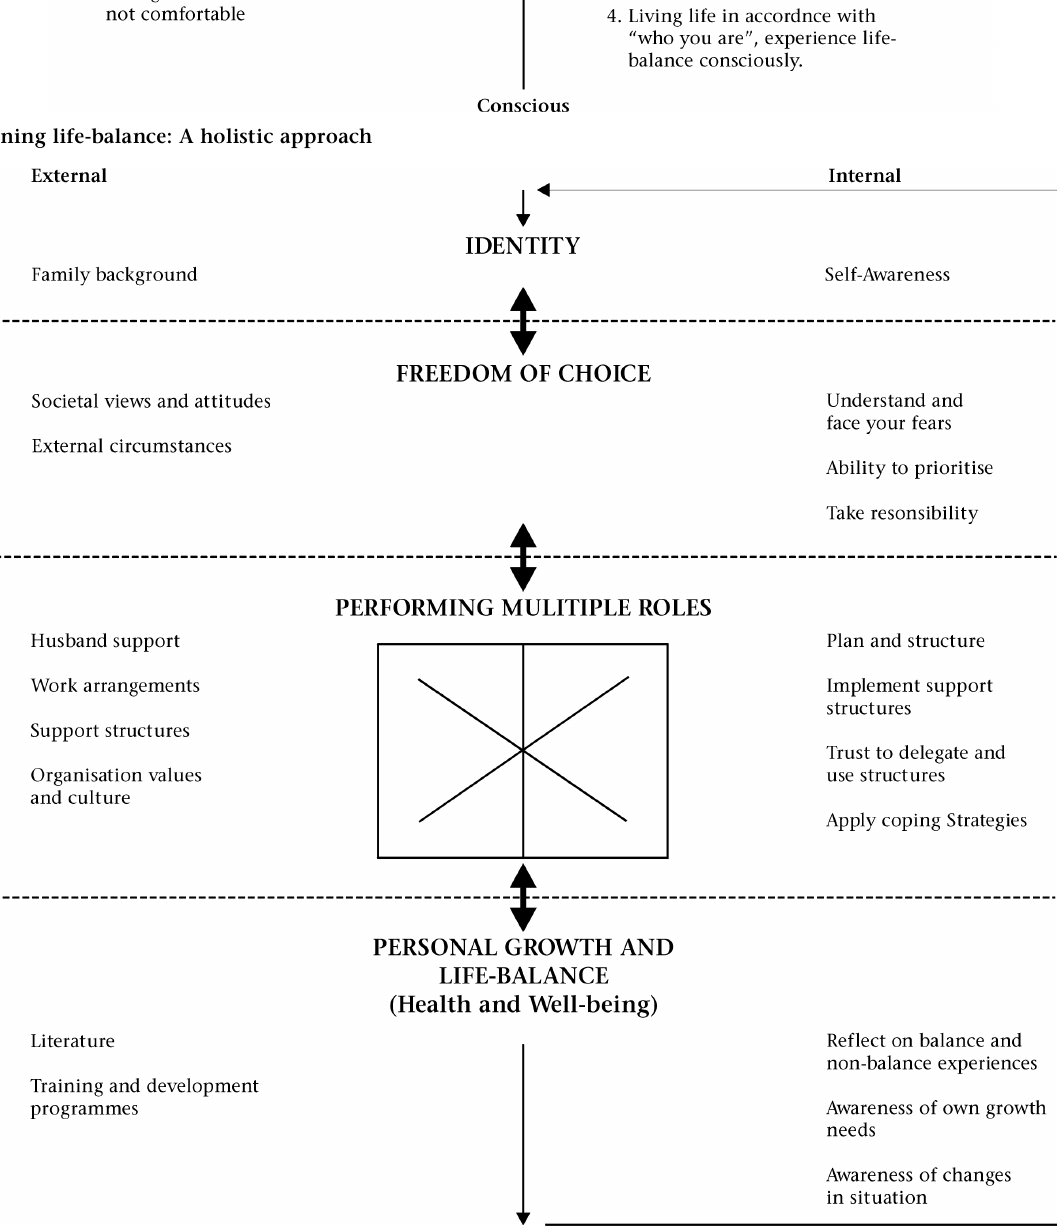
Figure 2: A life-balance process